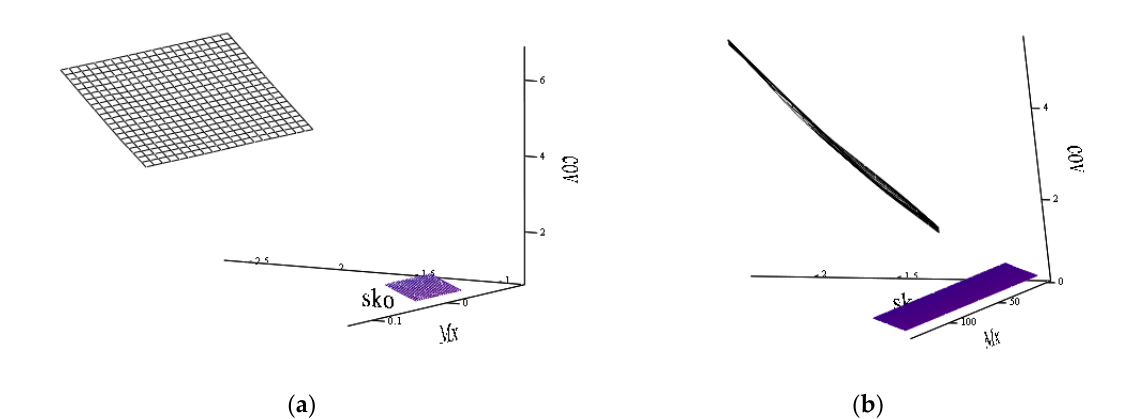
Figure 12. Graphs of standard deviation, mathematical expectation and covariance. Black and white plane are the range of the legitimate traffic values, purple is the range of the total traffic values: ( a ) At the fourth iteration; ( b ) At the fifth iteration.